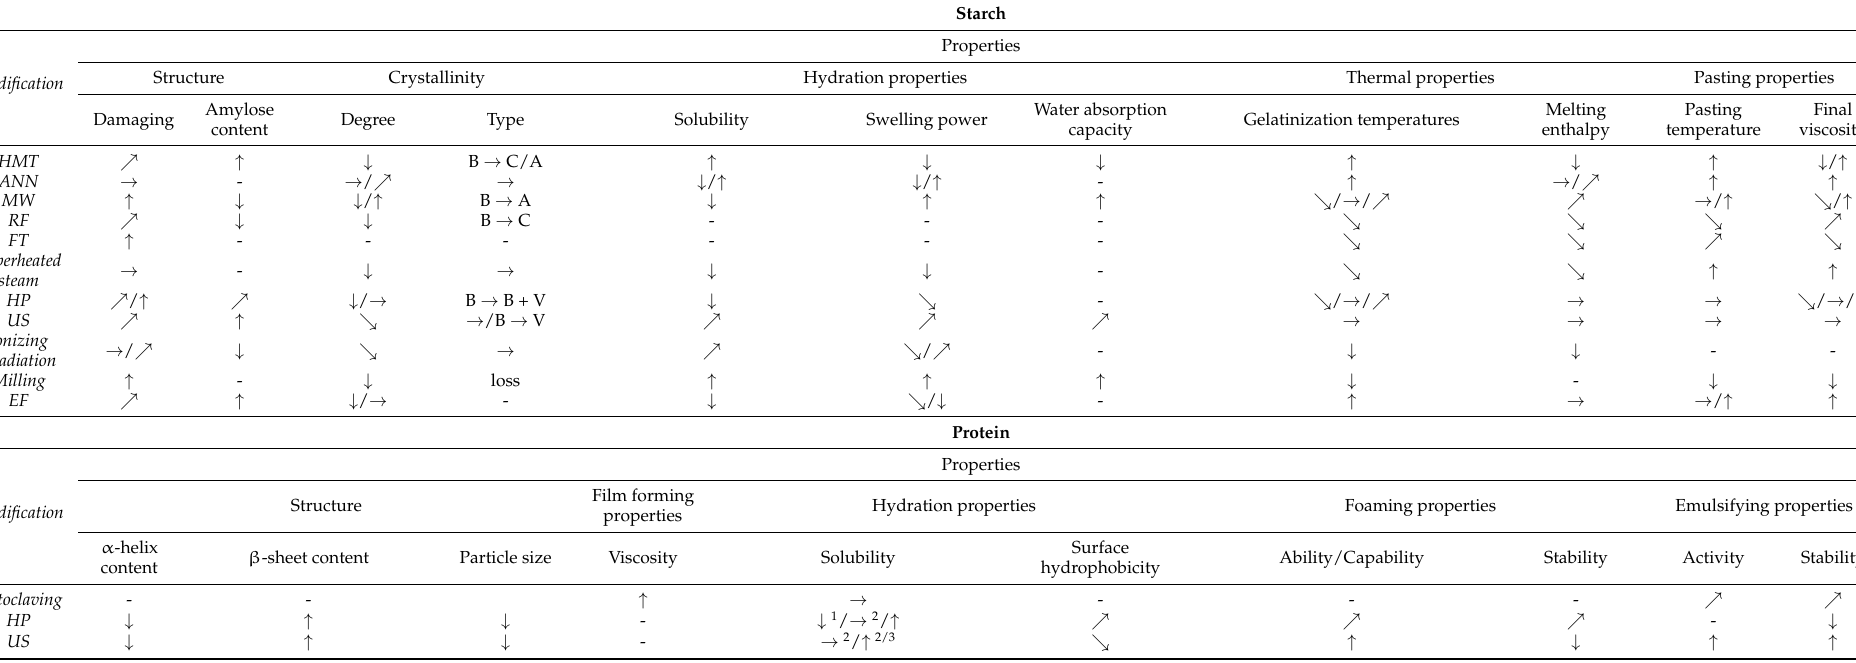
Table 2. General overview of changes induced by different physical modification methods on potato starch, potato protein, and potato-based films structure and properties (specific processing parameters or changes in processing parameters are not considered here, but can be looked up above). Abbrevations and references: HMT (heat moisture treatment) [15,29,67,73–75], ANN (annealing) [20,77,78], MW (microwave) [30,68,87,88,90,91], RF (radio frequency) [90,92], FT (freezing and-thawing) [93,94], Superheated steam [97], HP (high pressure) [25,100,107–109], US (ultrasound) [115–124], Ionizing irradiation [129–133], Milling [134–136], EF (electric field) [138,140], G’ (storage modulus), WVP (Water vapor permeability). Meaning of symbols: ↑ (increase), ↓ (decrease), → (no sig. influence), (cid:37) (slight increase), (cid:38) (slight decrease), - (no data available). Meaning of superscript numbers: 1 (for patatin at pH 6), 2 (at pH 7), 3 (at pH 12), 4 (for potato starch-lauric acid-complexes), 5 (for potato starch-hibiscus extract-based